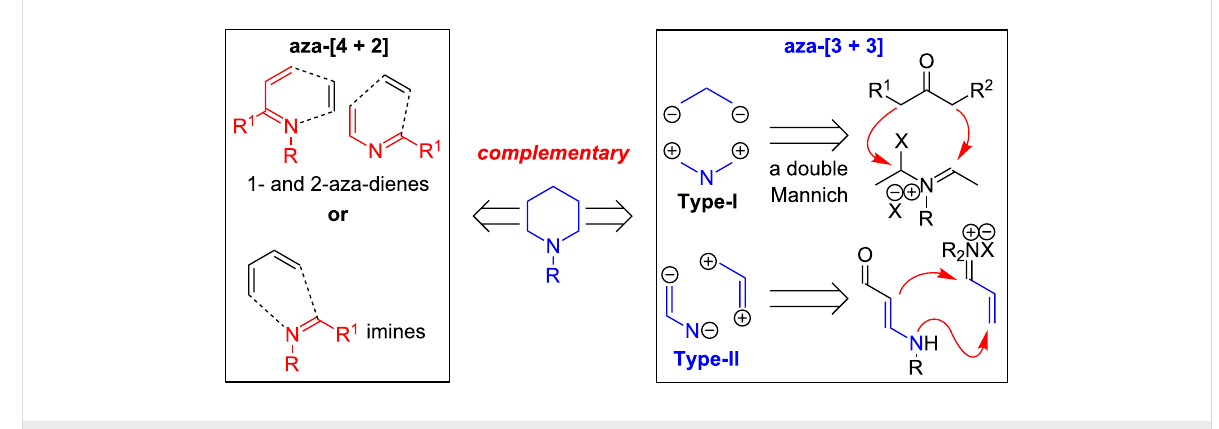
Figure 1: An aza-[3 + 3] annulation.